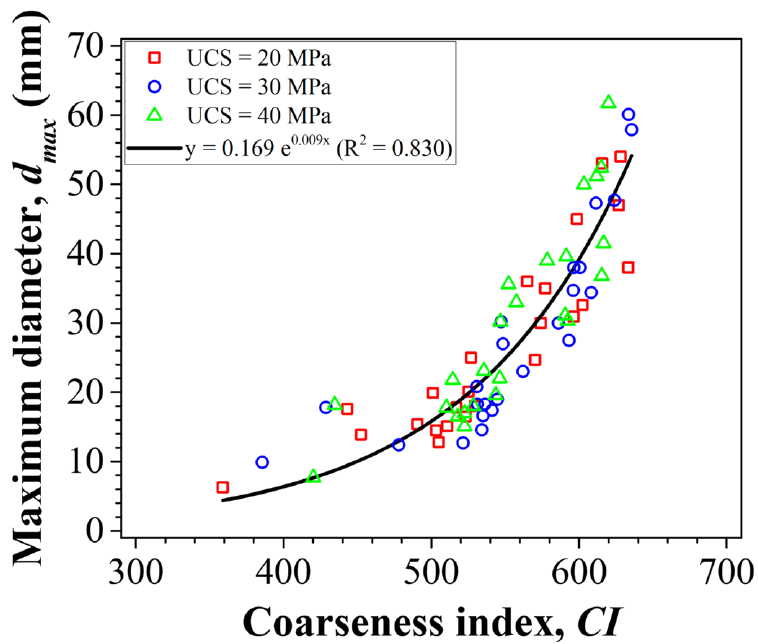
Figure 6. Relationship between CI and maximum diameter.